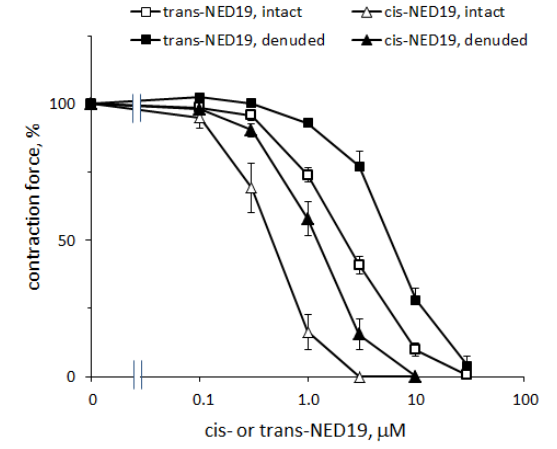
Figure 8. Concentration–response curves of aortic rings relaxation in response to cis- and trans-NED 19 with intact and denuded endothelium. The contraction force was measured 10 min after adding of each concentration of cis - or trans -NED 19. The data are the means + SEM from four independent experiments. The concentration–response curves of aorta contraction in response to NE in control conditions and in the presence of 10, 30, and 100 µ M trans -NED 19 and 10 µ M cis -NED 19 are shown on Figure 9A. Trans -NED 19 at 10 µ M concentration shifted the concentration–response curve to the right by an order of magnitude. Trans -NED 19 at 30 and 100 µ M caused further shift of the curve to the right. However, at these concentrations trans -NED 19 reduced the maximal force of contraction several-fold. The